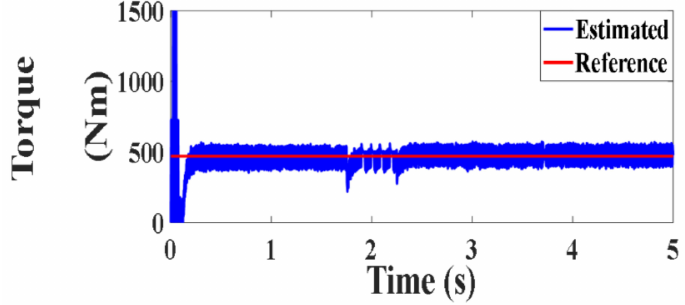
Figure 54. Developed torque under PVC (Nm).